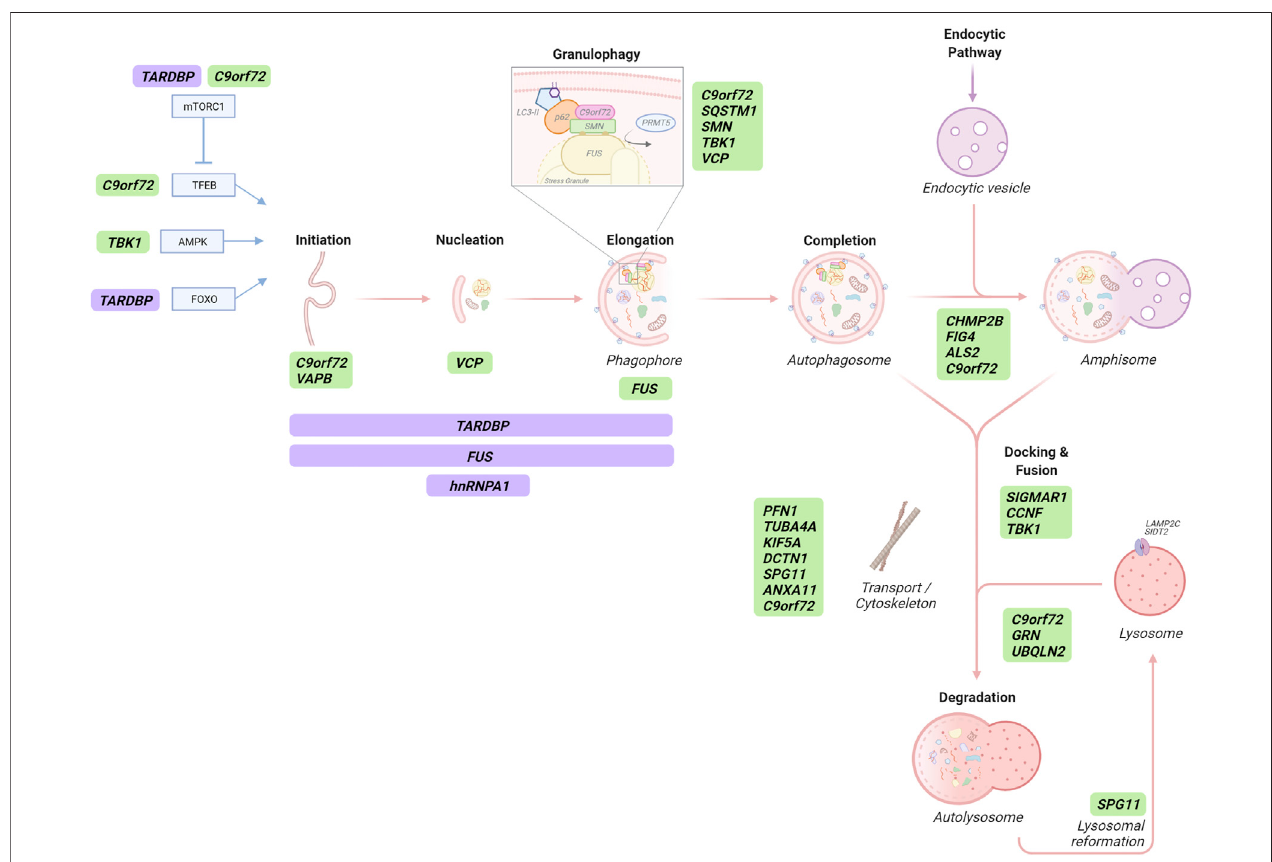
FIGURE 3 | The role of ALS/FTD-associated genes in autophagy-dependent RNA catabolism. Several stages of the autophagy pathway, in addition to selective autophagic degradation of stress granules, are affected by ALS/FTD-linked gene (green) products, some of which are RBPs that transcriptionally and/or post- transcriptionally regulate autophagy-related proteins (purple). Autophagy initiation is transcriptionally regulated by TFEB, AMPK and FOXO which can be affected by C9orf72proteinandrepeatRNA/DPRs, TBK1andTDP43( TARDBP ),respectively.TFEBactivityismodulatedbymTORC1whichisalsoregulatedbyC9orf72and TDP43 proteins. C9orf72, VAPB, VCP and FUS proteins play roles in different stages of autophagosome formation. Proteins participating in autophagosome formation are also post-transcriptionally regulated by TDP43, FUS and hnRNPA1 proteins. Selective SG degradation - termed granulophagy - can be mediated by C9orf72, p62 ( SQSTM1 ), SMN, TBK1 and VCP proteins. CHMP2B, FIG4, ALS2 and the C9orf72 protein participate in the maturation of autophagosomes to form amphisomes in the intersection with the endocytic pathway. SIGMAR1 , CCNF and TBK1 gene products are required for appropriate autophagosome-lysosome membrane fusion. Retrograde transport of autophagic structures contributes to proper autophagy fl ux and it is affected by ALS/FTD-linked PFN1 , TUBA4A , KIF5A , DCTN1 and SPG11 genes, coding for proteins of the vesicle transport machinery. Likewise, the C9orf72 protein is proposed to contribute vesicular traf fi cking, and annexin A11 (ANXA11) plays a role in RNA granule-lysosomal traf fi cking. Appropriate lysosomal degradative capacity of autophagic cargo is affected by ALS/FTD-linked proteins encoded by C9orf72 , GRN and UBQLN2 . Finally, spatacsin ( SPG11 ) is involved in lysosomal reformation.